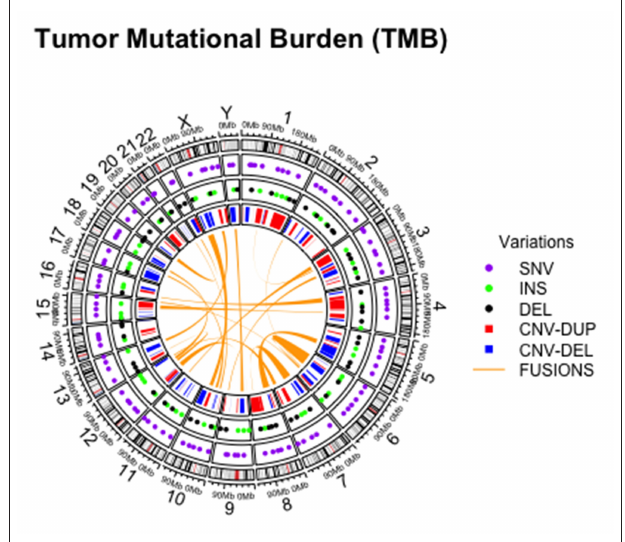
FIGURE 2 | Graphical representation of different alterations within tumor mutational burden analysis on cytological